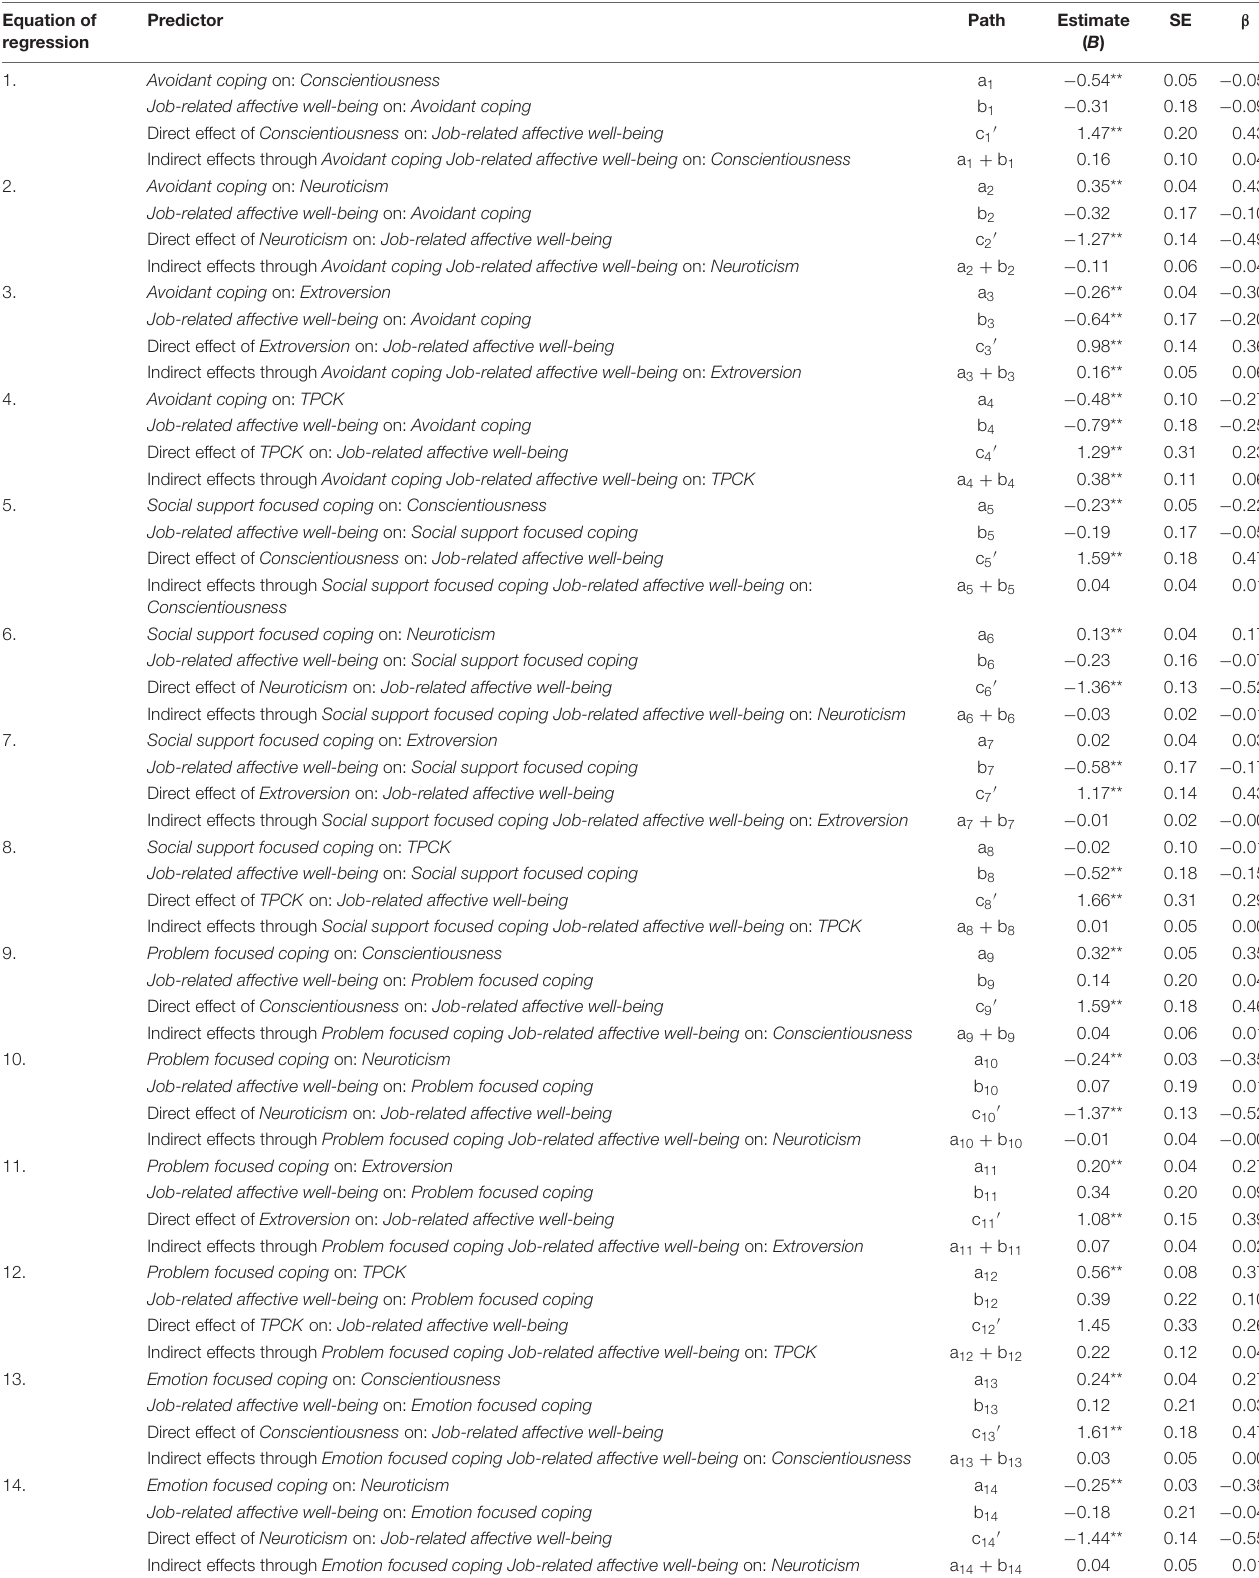
TABLE 4 | Direct, indirect, and total effects of personality dimensions and TPCK on job-related well-being and burnout through coping styles. Equation of regression